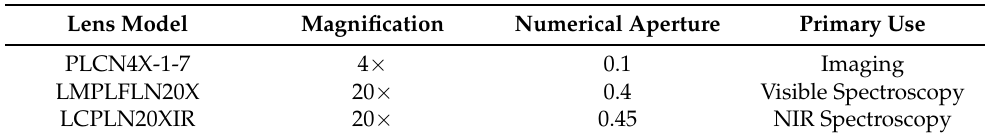
Table 2. List of Olympus objective lenses used in TRIUMF setup with their numerical apertures, magnifications and primary purposes. Lens Model